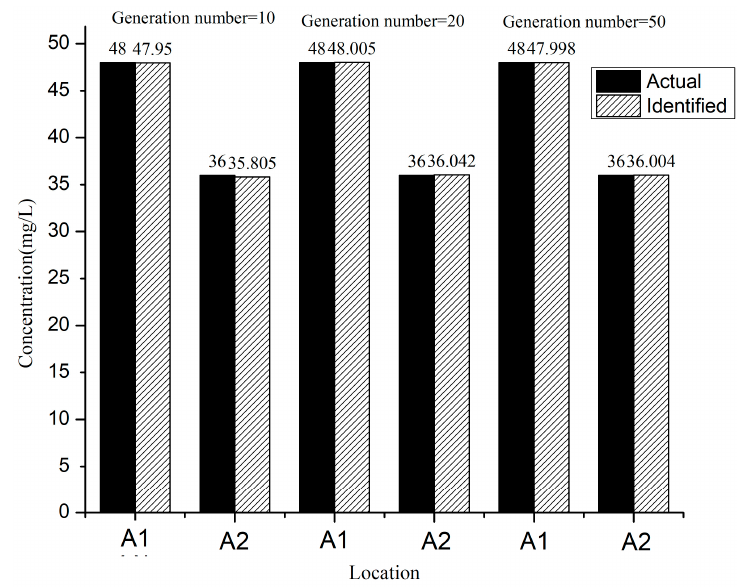
Figure 9. Effect of variation in generation number.